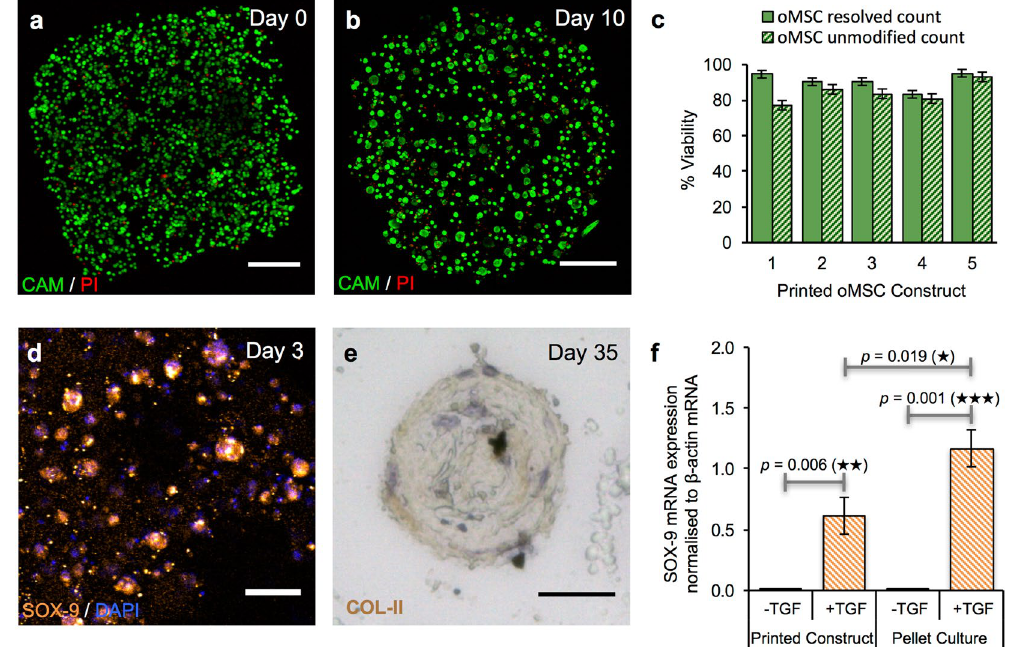
Figure 4. Growth and differentiation of printed oMSCs. ( a , b ) Image of a z-stack 3D reconstruction of live/ dead-stained printed oMSCs: ( a ) immediately after printing and; ( b ) after 10 days in culture with the TGF- β 3 supplement. (Scale bars = 250 μ m). ( c ) Graph of oMSC viabilities (including standard error of the mean) for five printed constructs immediately after transfer to culture medium. Viabilities were determined by using automated object counting, values of which were used either unmodified or resolved with respect to mean cell size. ( d ) Confocal fluorescence micrograph of immunocytochemistry performed on a printed oMSC construct after 3 days of culture with a TGF- β 3 supplement: SOX-9 (orange); nuclei (DAPI, blue); cytoplasm of live cells (CAM, calcein-AM, green). (Scale bar = 50 μ m). ( e ) High-magnification micrograph of immunohistochemistry performed on a printed oMSC construct after 35 days of culture with TGF- β 3 supplement; type II collagen (diaminobenzidine tetrahydrochloride (DAB), brown); nuclei (hematoxylin QS, blue). (Scale bar = 25 μ m). ( f ) Digital PCR measurements of SOX-9 mRNA expression in printed oMSC constructs ( n = 22) and oMSC pellet cultures ( n = 24) after 7 days in chondrogenic medium with or without supplementation of TGF- β 3. Each printed and pellet sample was replicated 4 to 6 times from four oMSCs sources, each extracted from a different sheep. SOX-9 expression was normalised to an endogenous β -actin control. Error bars represent standard deviations. Differences were tested by using a paired t -test, with two-tailed p values < 0.05 considered